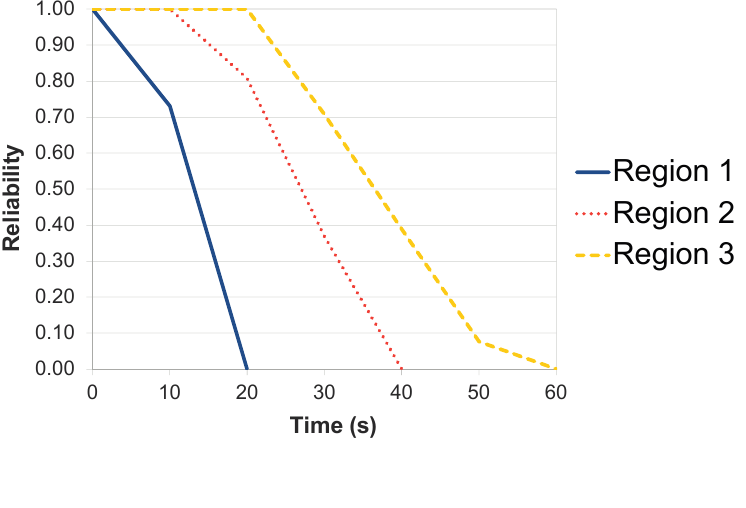
Figure 21. Reliability of the region in three different